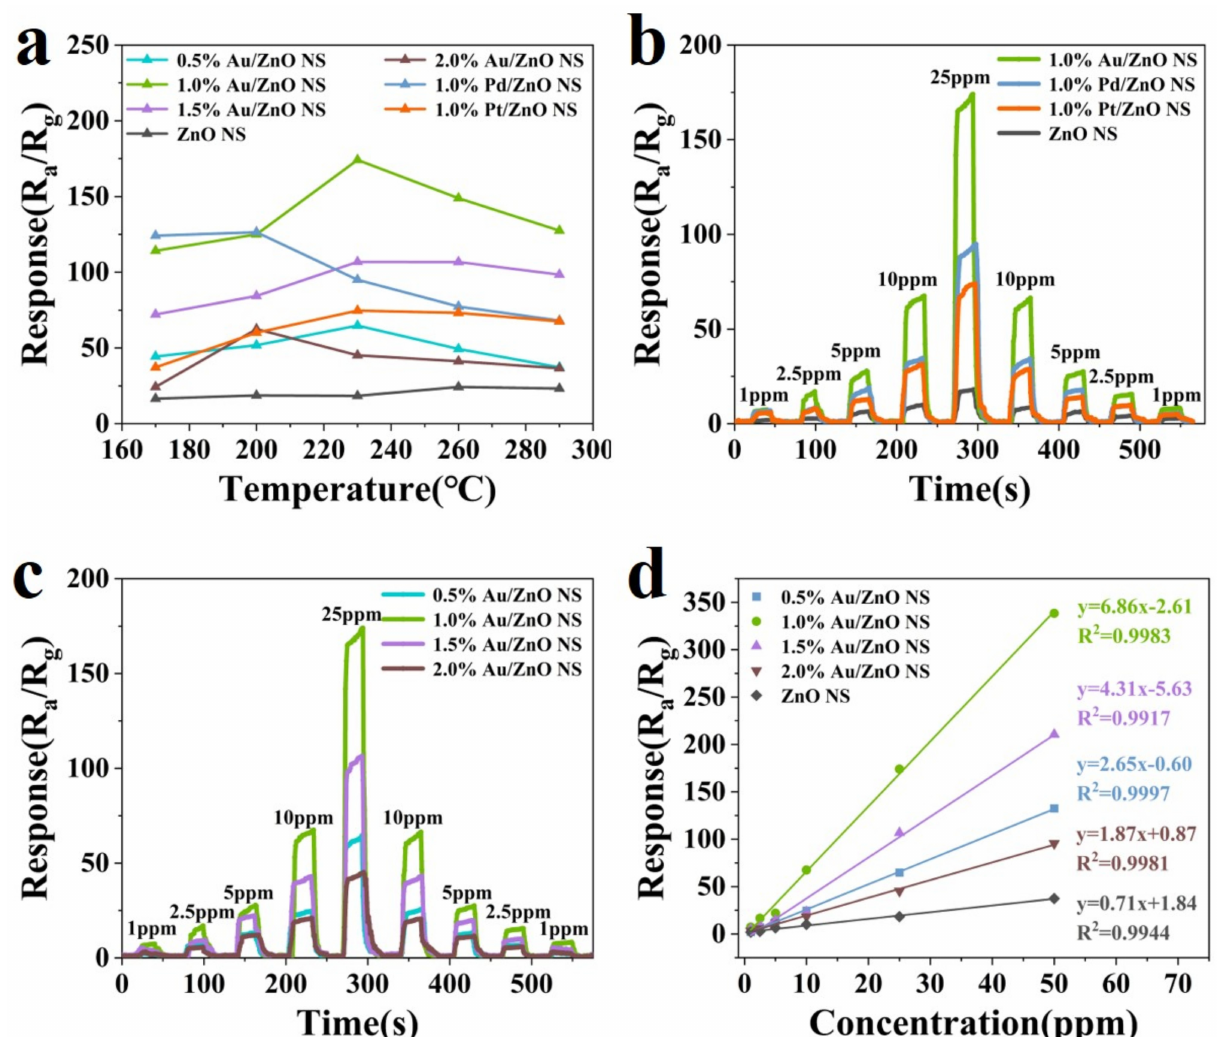
Figure 5. ( a ) Response of pure ZnO NS, 1.0% Pd/ZnO NS, 1.0% Pt/ZnO NS, and Au/ZnO NS to 25 ppm 3H-2B at working temperature from 170 ◦ C to 290 ◦ C. ( b ) Dynamic responses of 1.0% Au/ZnO NS, 1.0% Pd/ZnO NS, 1.0% Pt/ZnO NS, and pure ZnO NS to 1–25 ppm 3H-2B at 230 ◦ C. ( c ) Dynamic responses of 0.5% Au/ZnO NS, 1.0% Au/ZnO NS, 1.5% Au/ZnO NS, and 2.0% Au/ZnO NS to 1–25 ppm 3H-2B at 230 ◦ C. ( d ) Linear relationship between responses of 0.5% Au/ZnO NS, 1.0% Au/ZnO NS, 1.5% Au/ZnO NS, 2.0% Au/ZnO NS, and ZnO NS with 3H-2B concentrations (1–50 ppm) at 230 ◦